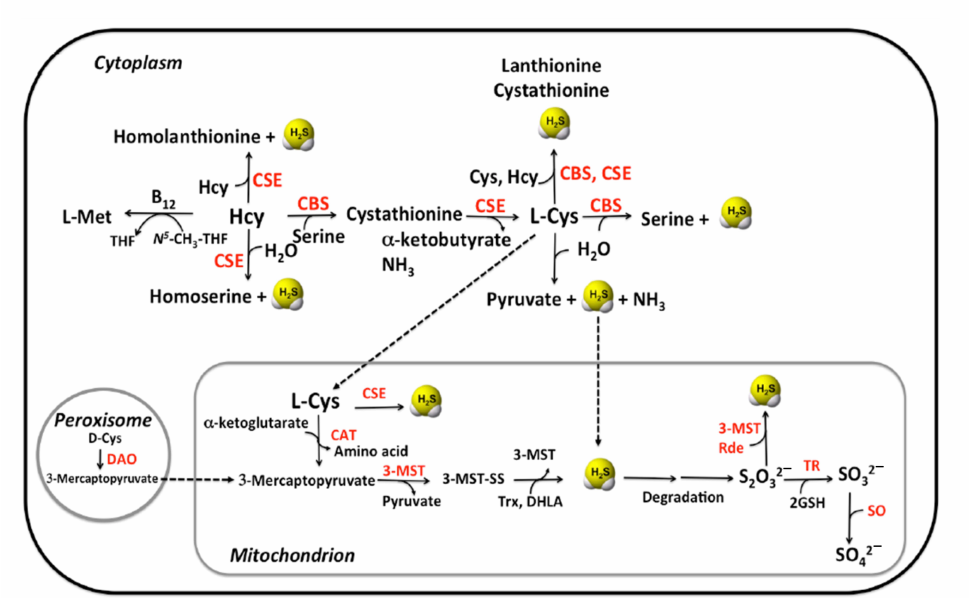
Figure 3. Biogenesis of H 2 S. Overview of reactions and compartments for the biosynthesis of H 2